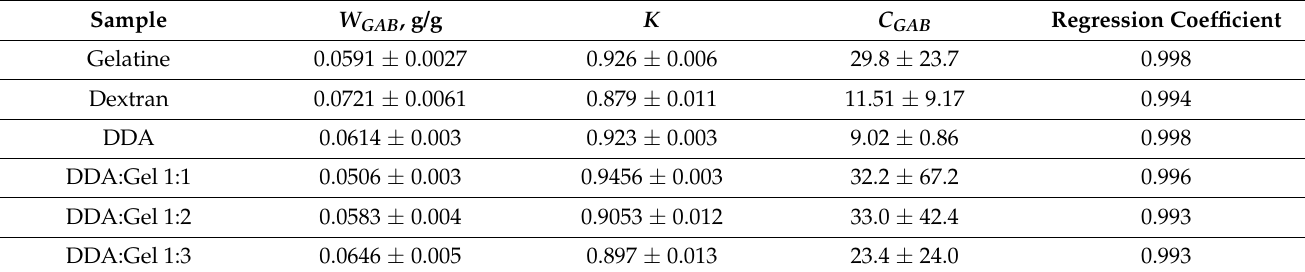
Table 3. GAB fitting parameters for the experimental sorption